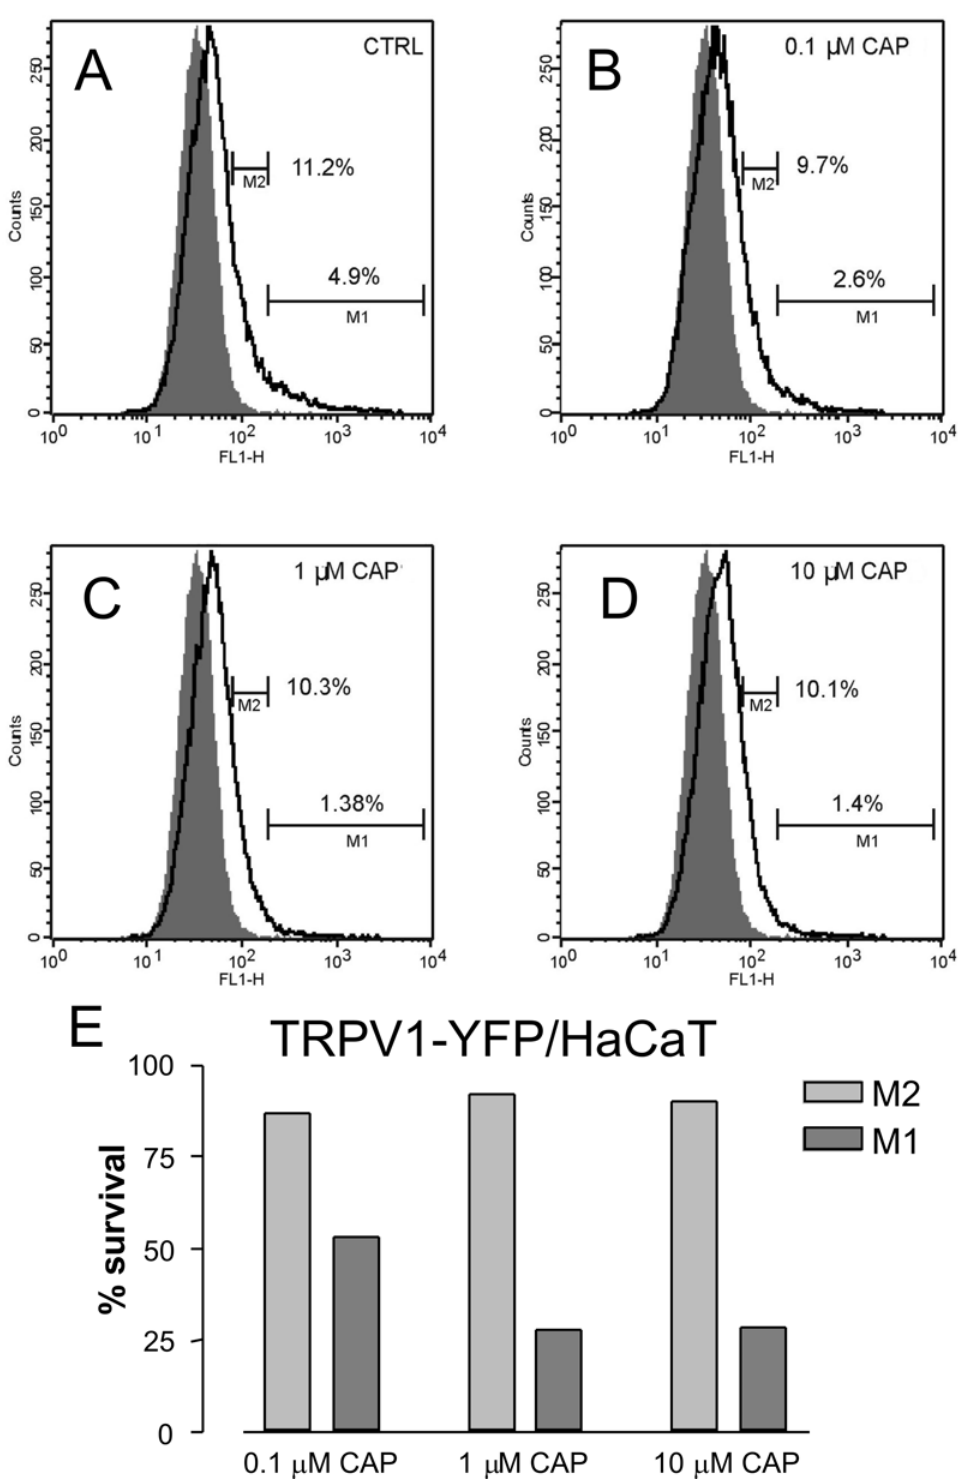
Figure 2. Transformed cells expressing low levels of TRPV1 were resistant to TRPV1-mediated capsaicin toxicity. NIH3T3 mouse fibroblasts expressing variable levels of TRPV1-YFP fusion protein were incubated in the absence of capsaicin (A) or with different capsaicin concentrations, 0.1 m M (B), 1 m M (C), 10 m M (D) for 30 9 , then propidium iodide was added and the flow-cytofluorometric analysis was performed. The M1 and M2 regions contain the intact (propidium iodide negative) TRPV1-YFP high and low positive cells, respectively. Only TRPV1 high positive cells were sensitive to dose dependent, TRPV1 mediated killing by capsaicin (E).